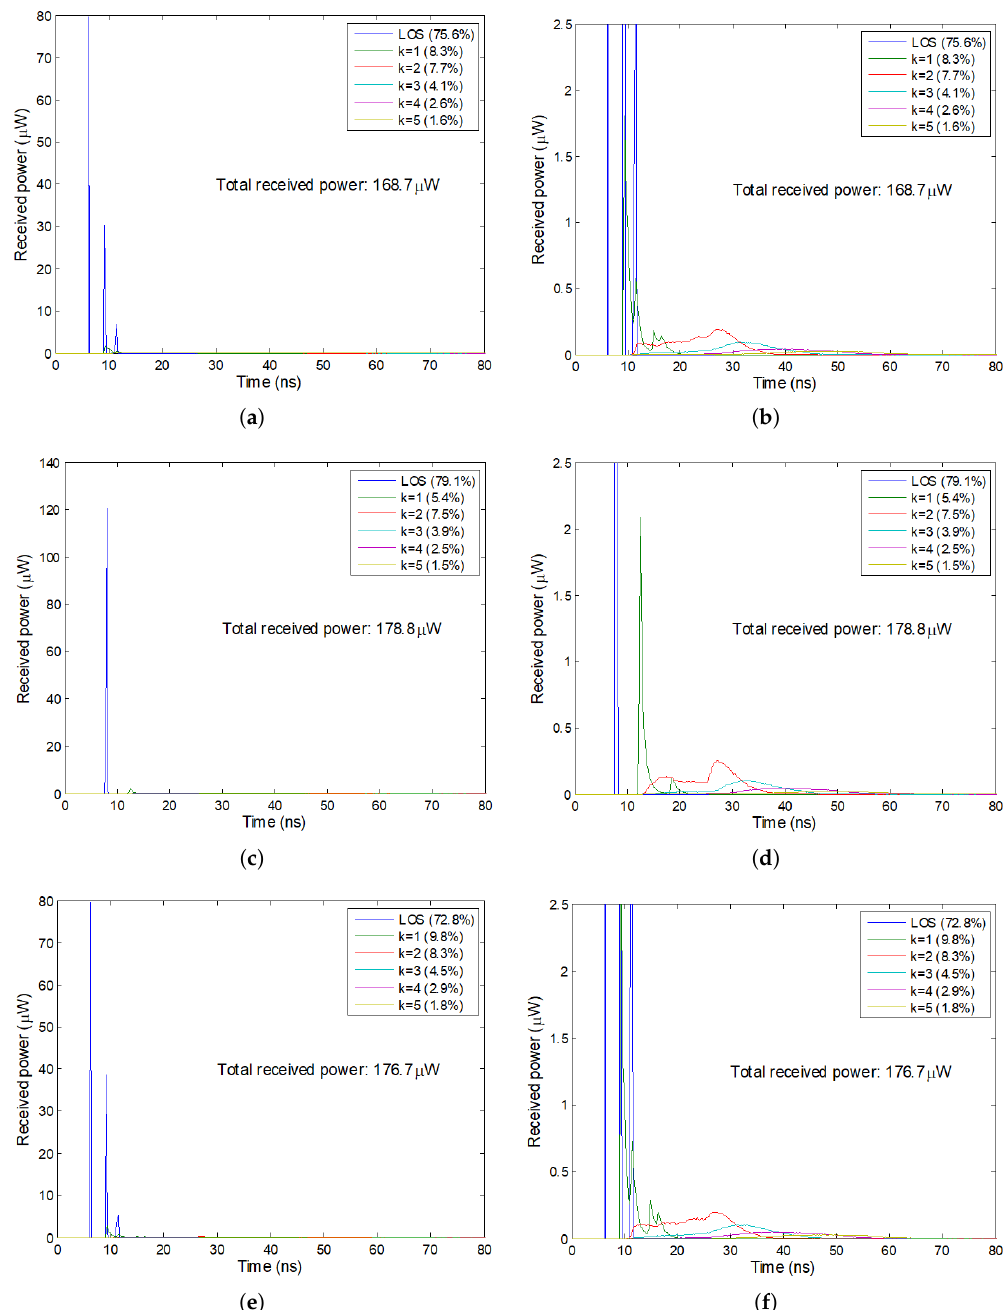
Figure 5. Simulated impulse responses at three locations: ( a ) Impulse response under lamp 1 (close to a window). ( b ) Zoom of impulse response under lamp 1. ( c ) Impulse response at the center of the room. ( d ) Zoom of impulse response at the center of the room. ( e ) Impulse response under lamp 4 (close to a corner). ( f ) Zoom of impulse response under lamp